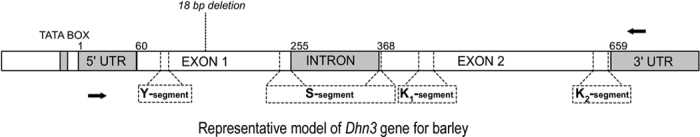
General structure of the Dhn3 locus in H. vulgare (Choi et al. 1999) that is conserved in H. spontaneum.Arrows show the location of primers used to amplify Dhn3 alleles in this study.